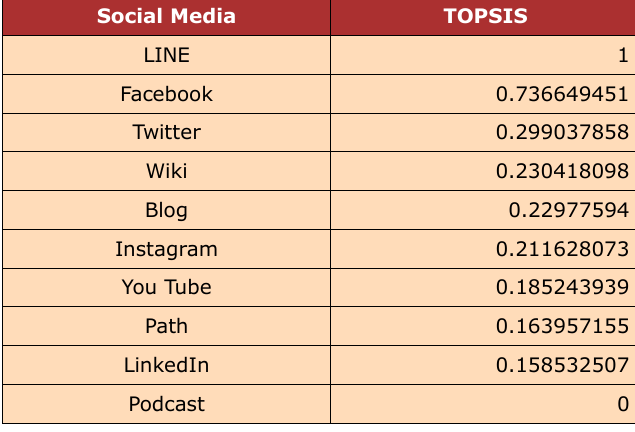
Table 6. TOPSIS value for social media